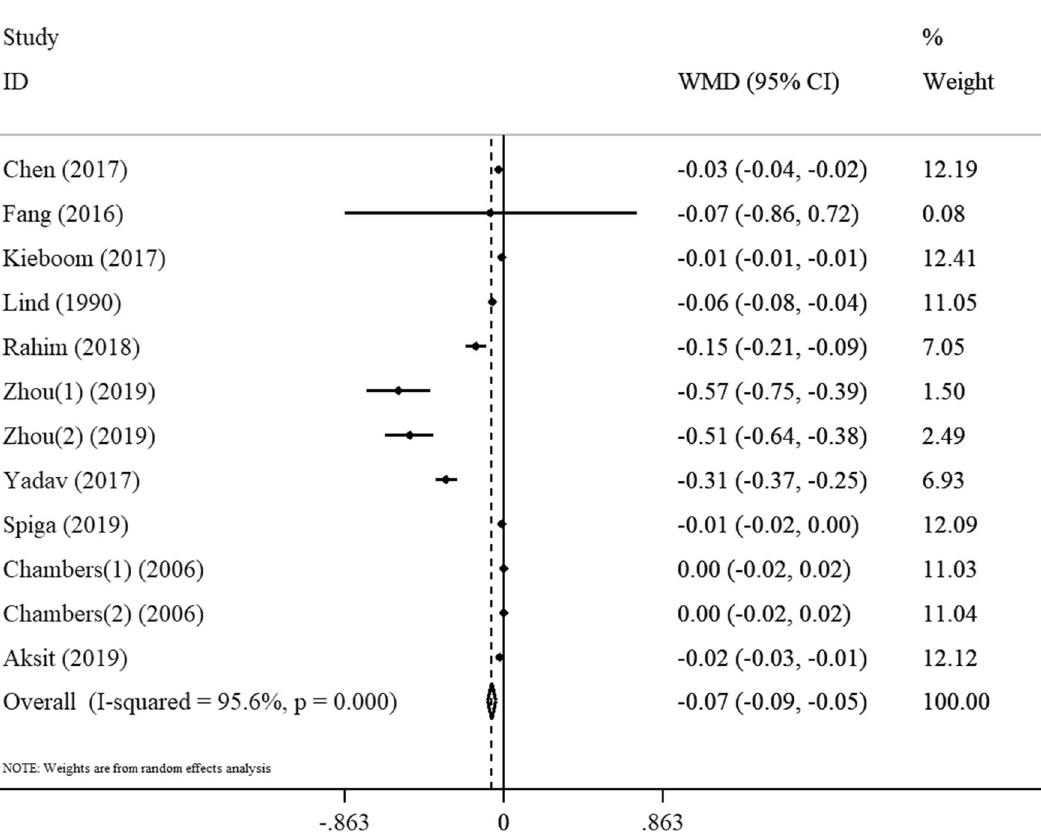
Figure 2. Forest plot for the association between magnesium level and prediabetes expressed as mean difference between case and control groups. The area of each square is proportional to the inverse of the variance of the WMD. Horizontal lines represent 95%Cis. Diamonds represent pooled estimates from random-effects analysis. WMD, weighted mean